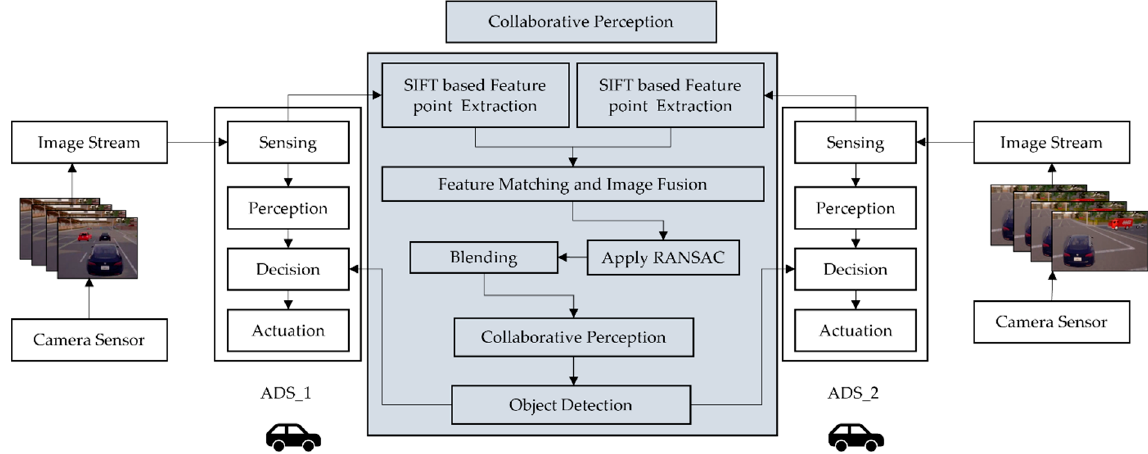
Figure 2. A proposed approach for collaborative perception.